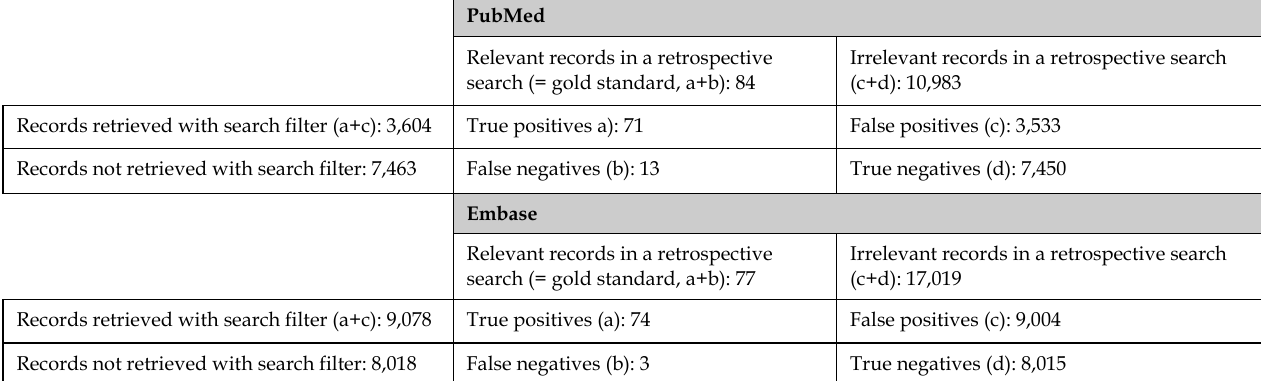
Table 6 Overview of the observational study search filter’s performance in PubMed and Embase